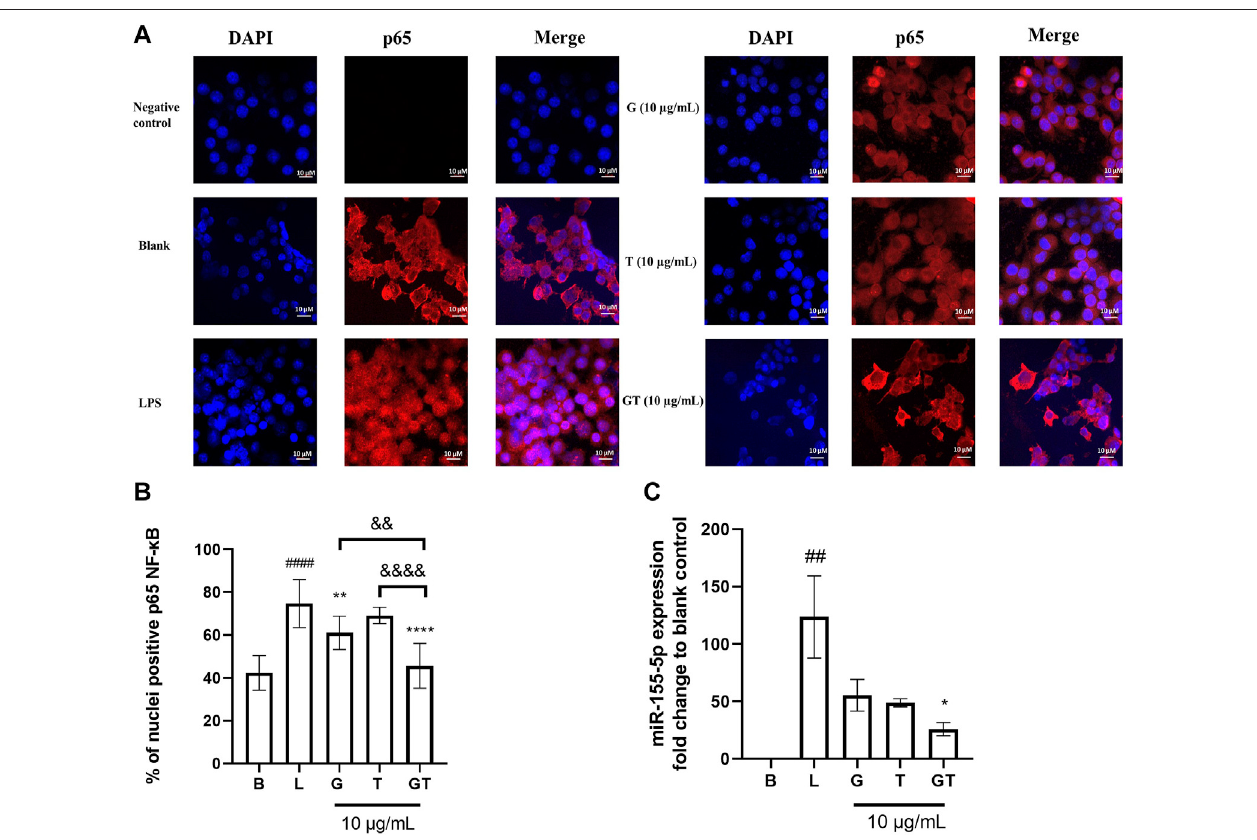
FIGURE3| Down-regulatedNF- κ BtranslocationandmiR-155-5pbyG,TandGT (A) RepresentativeimagesofG,T,andG-T5:2ininhibitingLPSactivatedNF- κ B p65 translocation inthe RAW 264.7 cells byimmuno fl uorescence staining. Images ( n ≥ 5) weretaken byusing a confocal microscope with ×60magni fi cation. Blue: DAPI in the nucleus, red: NF- κ B p65 in the RAW 264.7 cells (B) Quanti fi cation of % of nuclei positive p65 of staining in unstimulated, LPS stimulated macrophages with and without various treatments. Data points represent the mean ± standard deviation from the analysis of 9 separate cells. #### p < 0.0001 LPS (L) vs. Blank (B) , ** p < 0.01compared withL,**** p < 0.0001comparedwithL. ΔΔ p < 0.01 GTvs.G, ΔΔΔΔ p < 0.0001 GTvs.T (C) AveragedfoldchangeofmiR-155-5ptreatedwithG,Tor GT with the stimulation of LPS ( n = 3). ## p < 0.01 LPS (L) vs. Blank (B) , * p < 0.05 GT compared with